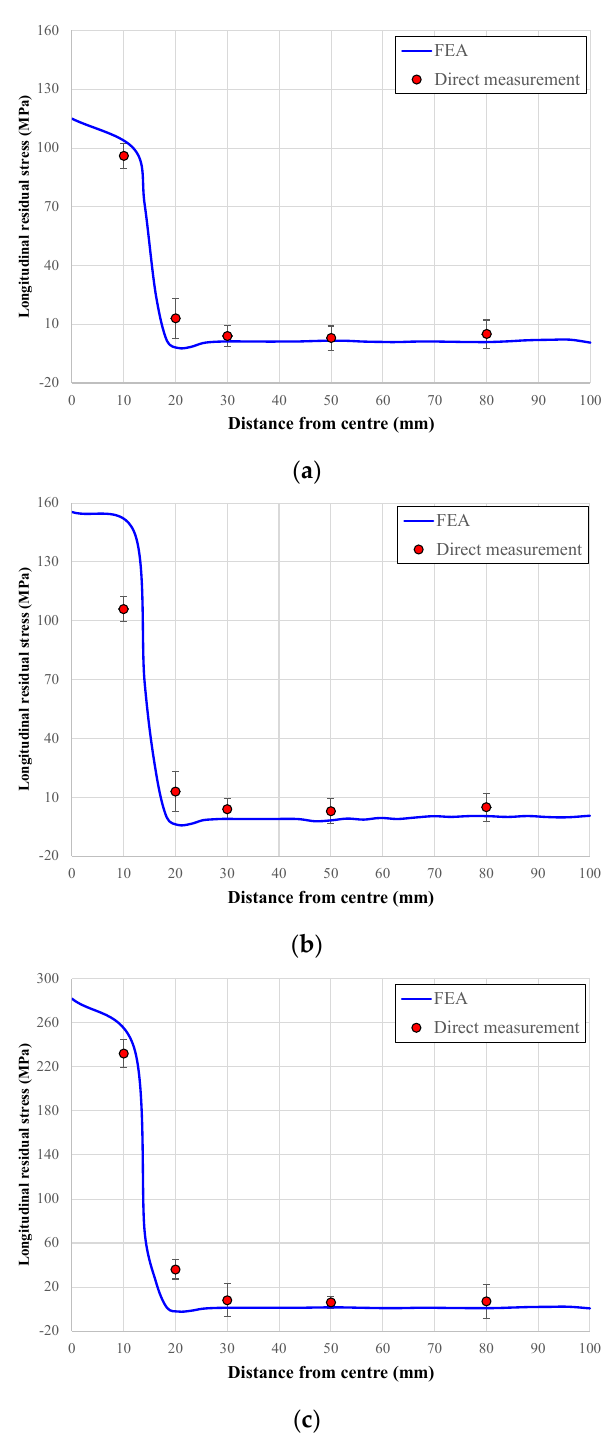
Figure 19. Comparison of FEA versus direct measurement: ( a ) Al 5083 H321; ( b ) Al 6061 T6; ( c ) Al 6082 T6.